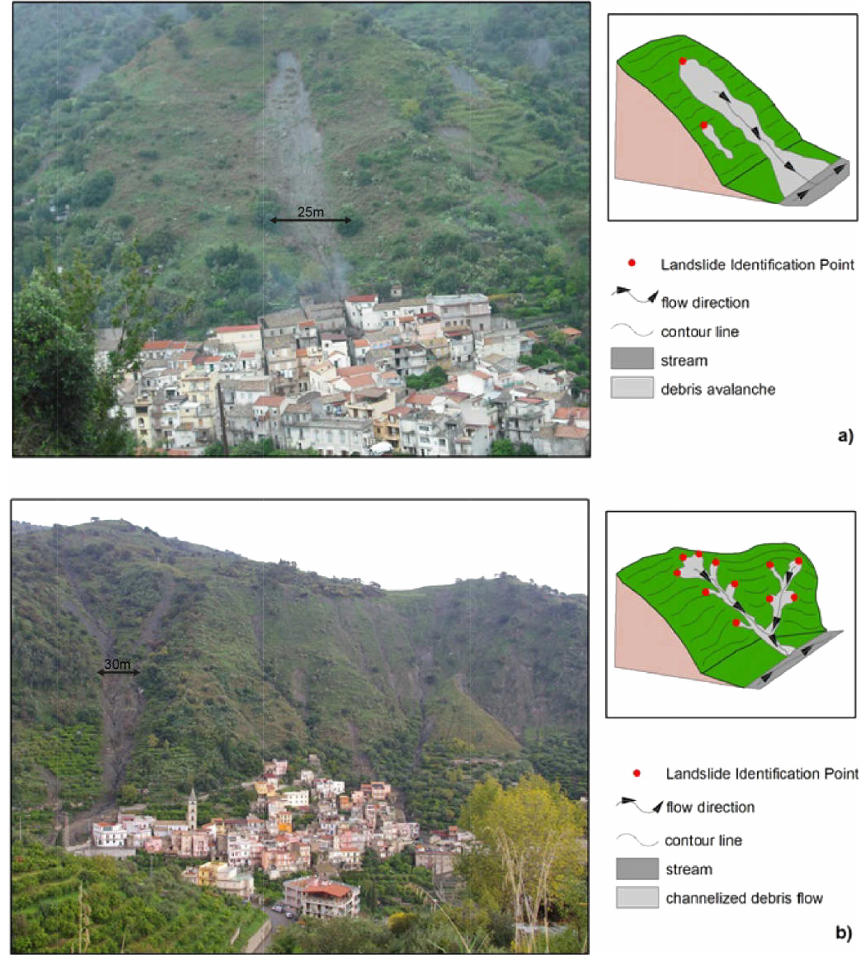
Figure 4. Overview of the area hit by the 2009 event: (a) Guidomandri village: debris avalanches are observable on the triangular facets parallel to the coast; (b) Itala village: channelized debris flows crossing the urbanized